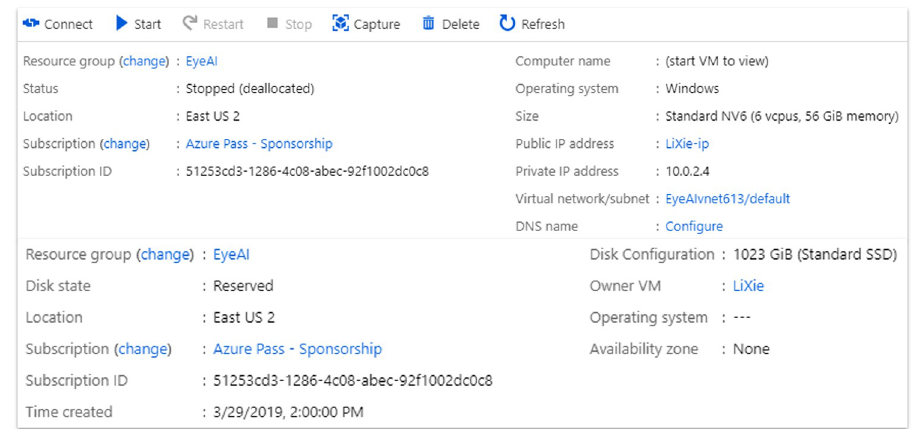
Fig 5. Screenshot of the Microsoft Azure ™ virtual machine. A Virtual Machine was created on Microsoft Azure East US server. 6 CPUIs were avaialble to us on this Virtual Machine, and it was used for training and validation process.